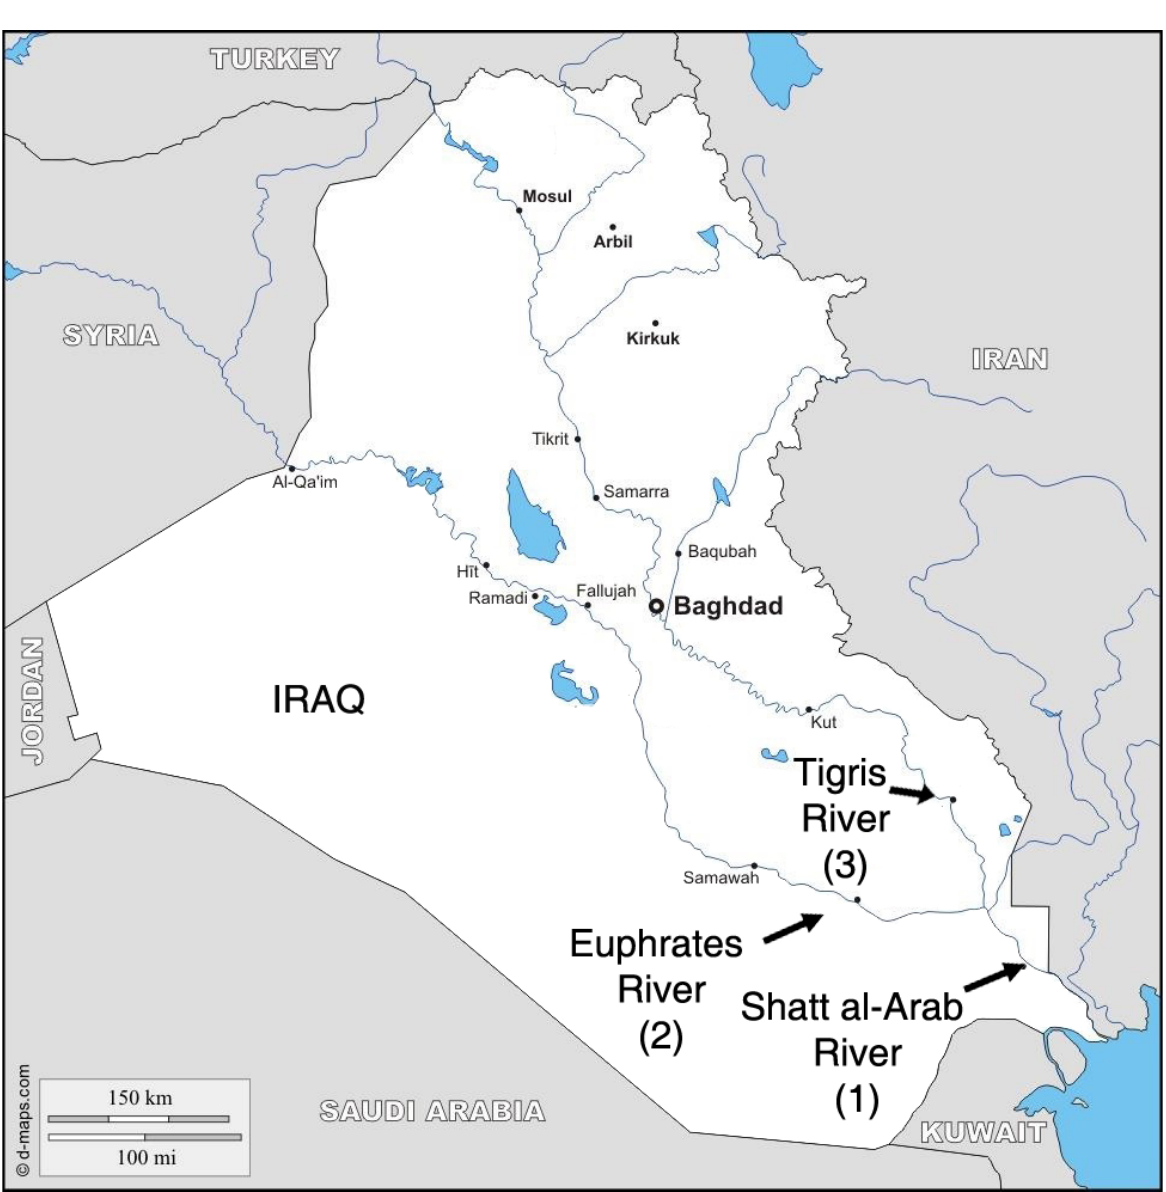
Figure 1. Sampling locations where common carp ( Cyprinus carpio ) were collected: the Shatt al-Arab (1), Euphrates (2) and Tigris (3) rivers.